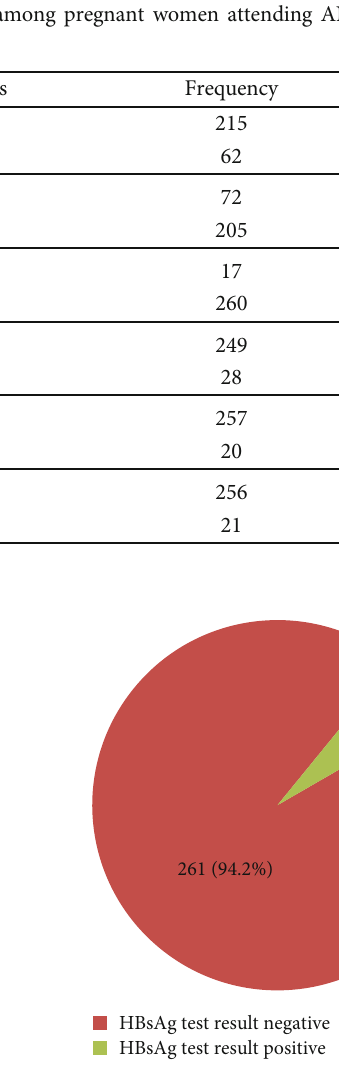
Figure 1: Prevalence of hepatitis B virus among pregnant women attending antenatal clinic at public health facilities in Nekemte town, Western Ethiopia,